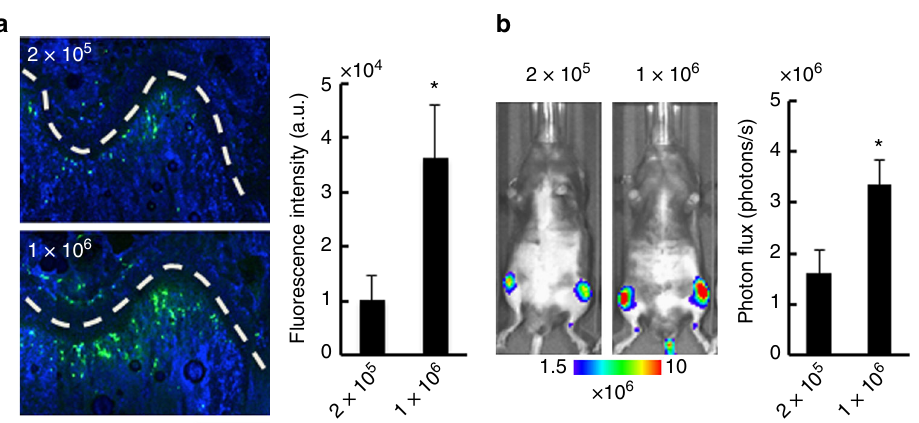
Fig. 3 Injection of larger number of cancer cells enhances bone metastasis development. a Fluorescence microscopic analysis of cancer cells in bone marrow of the femur. Representative fl uorescence images of the femur (left) and fl uorescent intensities of cancer cells (right) at 30 min after CA injection of green- fl uorescently labeled LLC/luc cells (2.0 × 10 5 or 1.0 × 10 6 cells). Cells were stained with Hoechst dyes (blue). White-dashed lines indicate growth plates. A scar bar is 200 μ m. n = 4, * P < 0.05 (two-side student ’ s t -test). b Development of bone metastasis after injection of different number of LLC/luc cells. Representative BL images (left) and BL intensity in hind limbs (right) at 14 days after CA injection of LLC/luc cells (2.0 × 10 5 or 1.0 × 10 6 cells). n = 8, * P < 0.05 (two-side student ’ s t -test). Error bars indicate